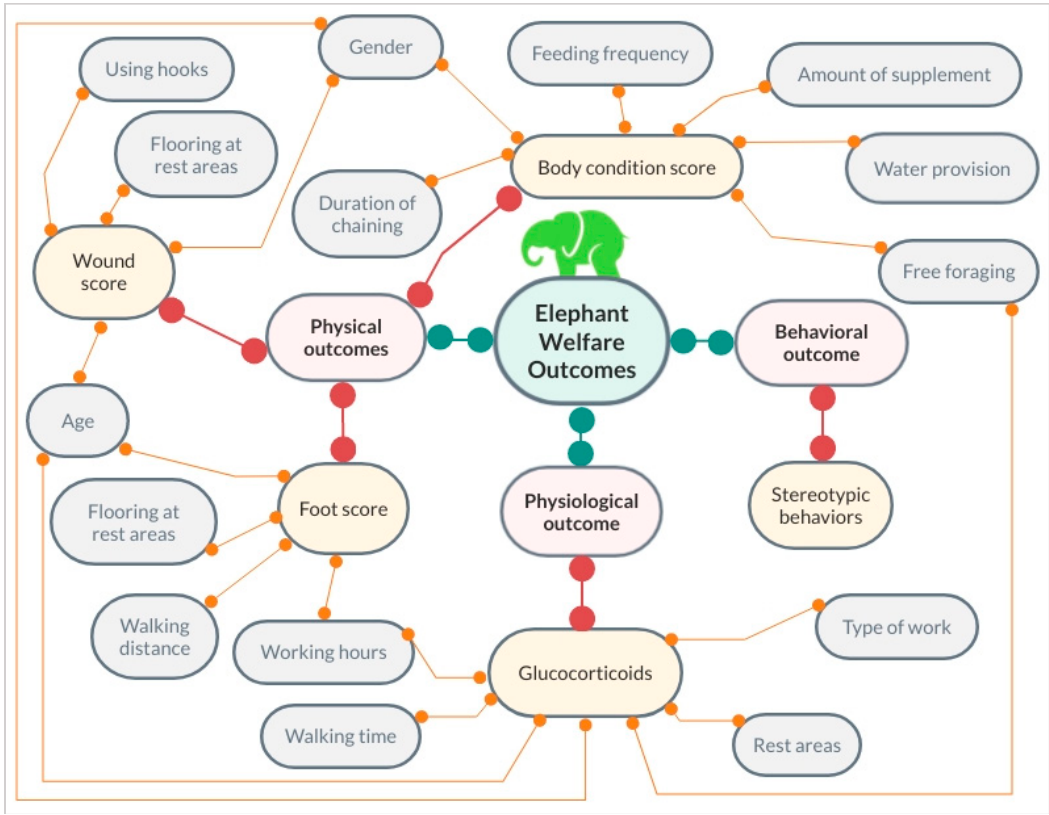
Figure 1. Associations between physical (foot score, wound score, body condition score), physiological (glucocorticoids), and behavioral (stereotypic behavior) outcomes and independent variables based on studies conducted on tourist elephants in Thailand [6,29–31,34,40,41]. Green lines indicate general outcome categories, red lines identify measured outcomes, and orange lines connect the independent variables to specific welfare outcomes.